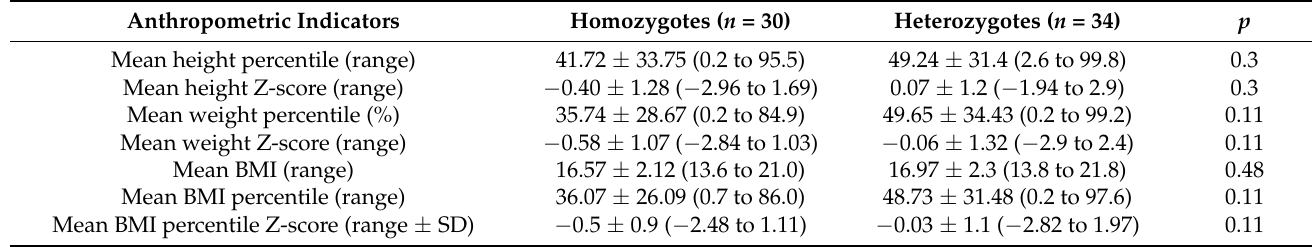
Table 5. Anthropometric indicators by genotype group.